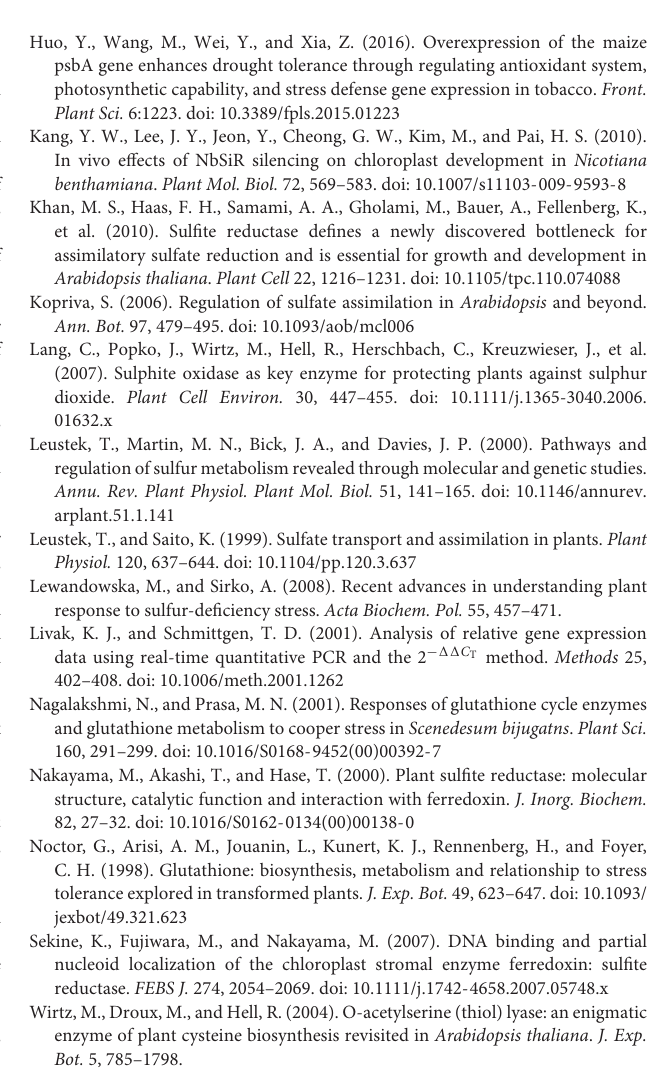
FIGURE S1 | Phylogenetic tree based on the amino acid sequence alignment of plant SiRs. These plant species include Arabidopsis